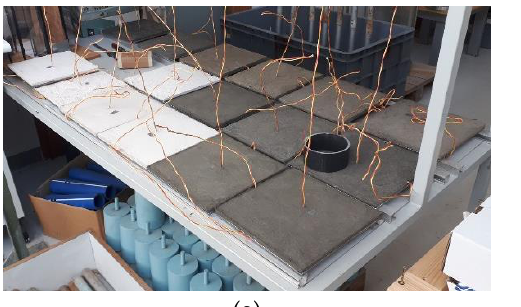
Figure 3. ( a ) Specimens in the process of curing; ( b ) specimen schematic representation and re- spective dimensions.